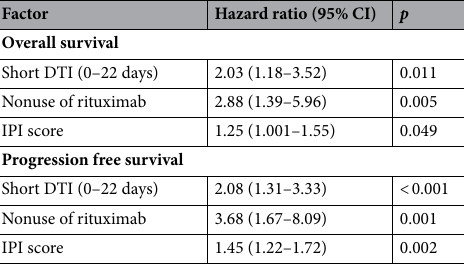
Table 3. Factors associated with survival by multivariate analysis. DTI diagnosis-to-treatment interval, IPI International Prognostic